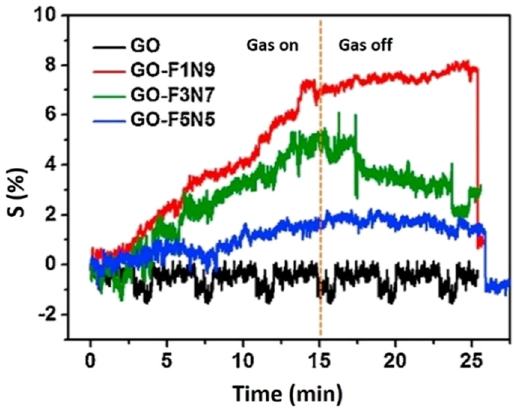
Figure 14: Sensing behaviour of f - GO under 100 ppm of NH 3 gas at room temperature. Reproduced from ref. [ 119 ] .